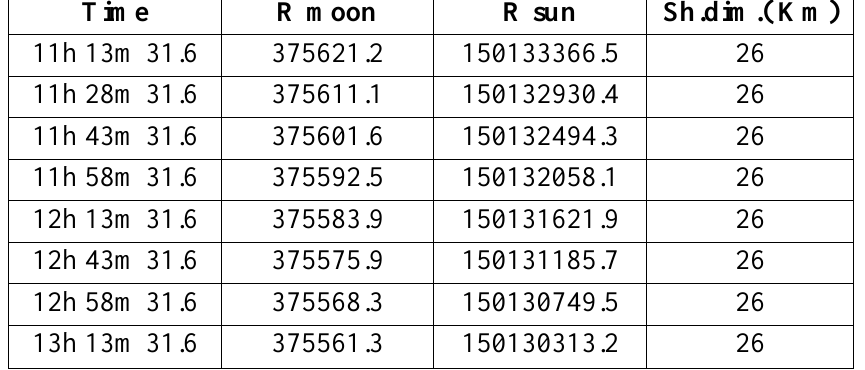
Table 8: YY = .3929685 Total CENTRAL ECLPSE